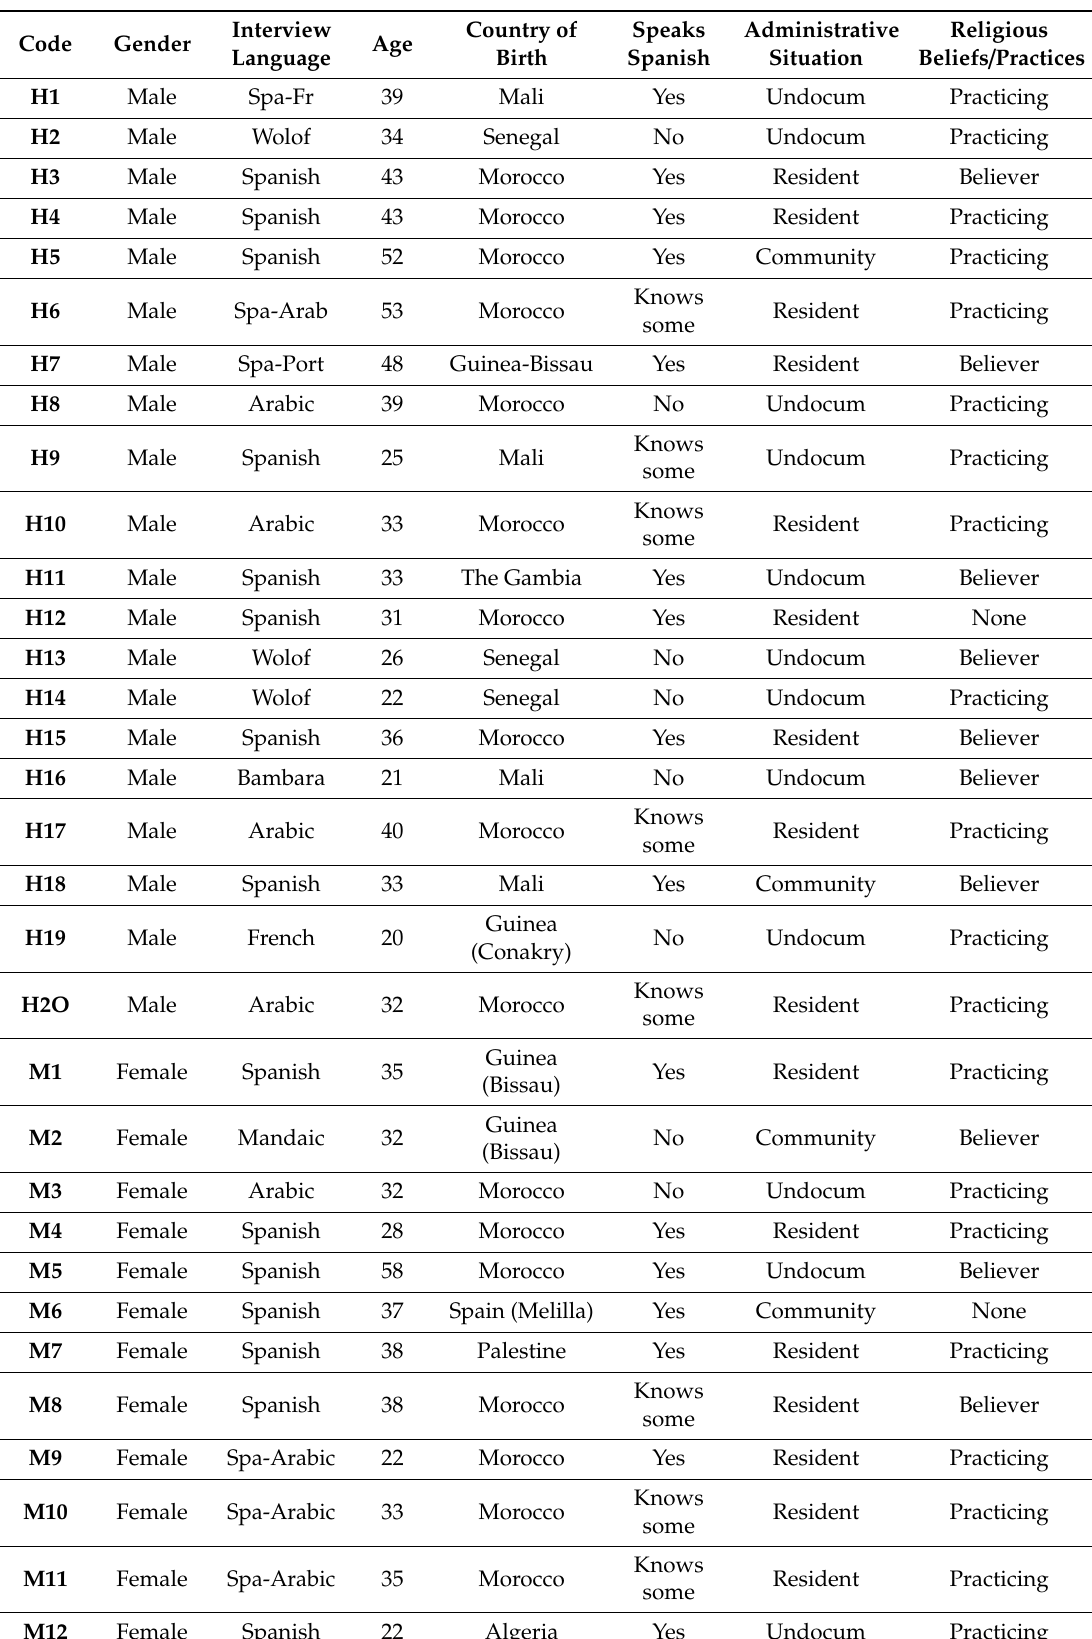
Table 1. Characteristics of the